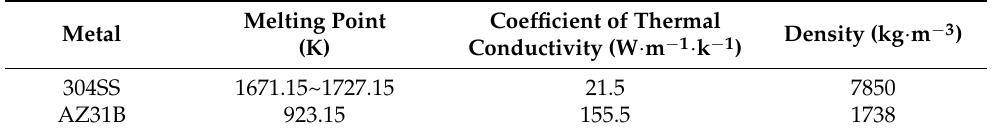
Table 2. Part physical properties of the 304 stainless steel and AZ31B.